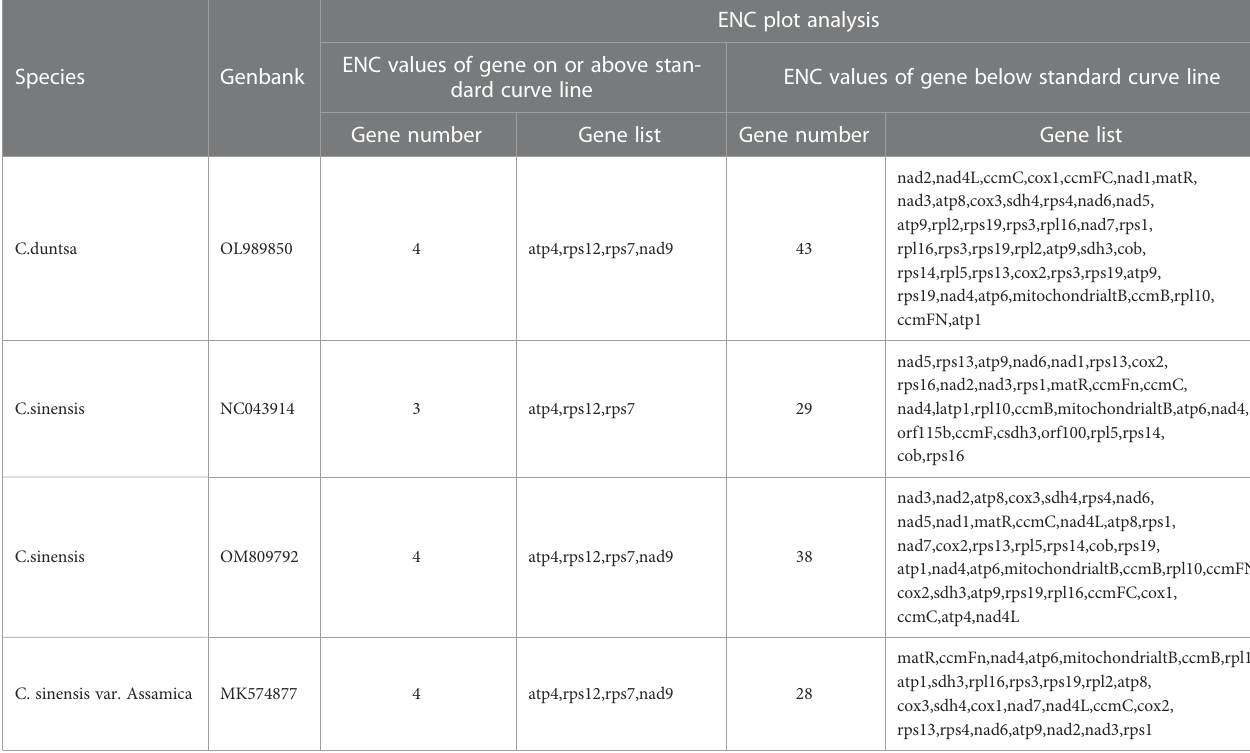
Species Genbank